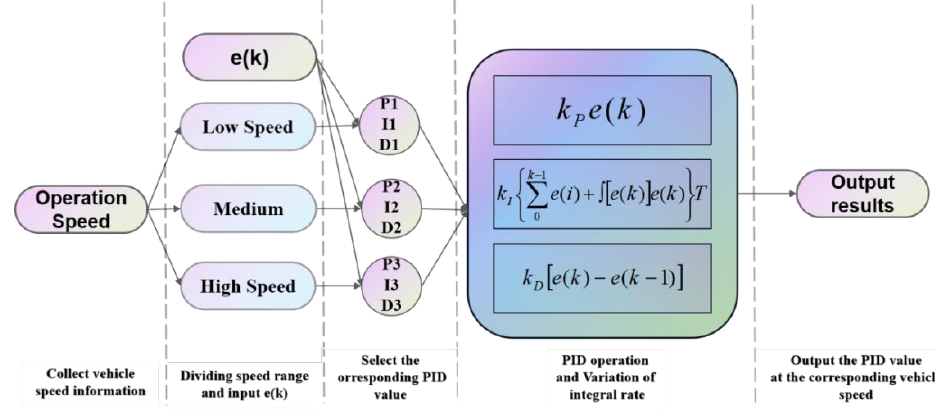
Figure 15. EVPIVS-PID control algorithm structure principle.